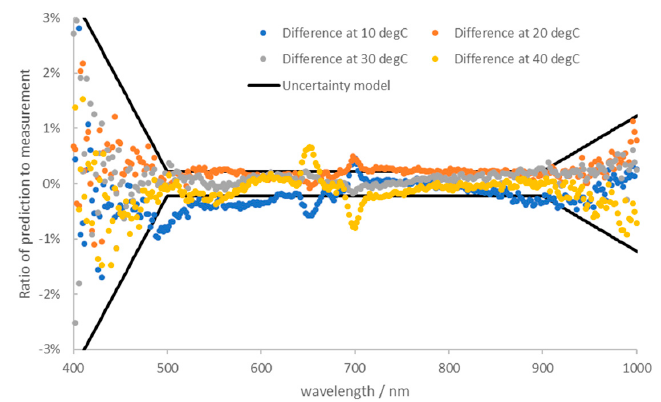
Figure 9. Residual from the measurements to the fit model at different wavelengths. The black curve gives the assumed uncertainty associated with the model (the plus-zero term in Equation (5)).